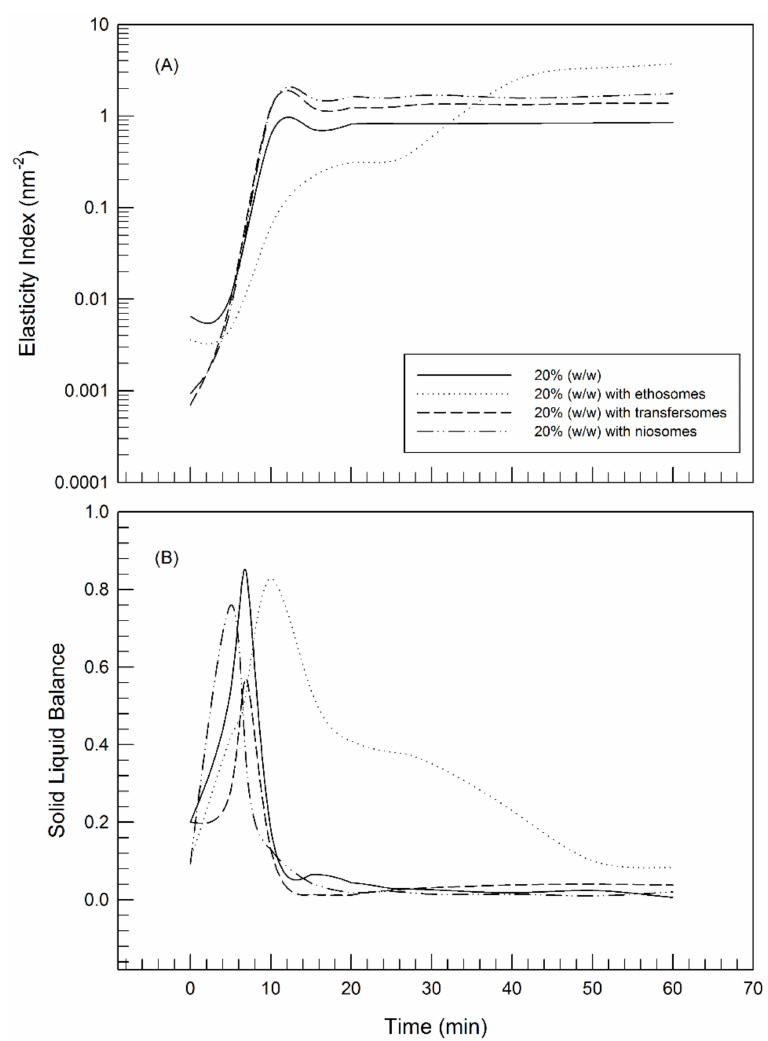
Figure 6. Elasticity Index (EI) ( A ) and Solid Liquid Balance profile ( B ) versus time for 20% poloxamer 407 with and without